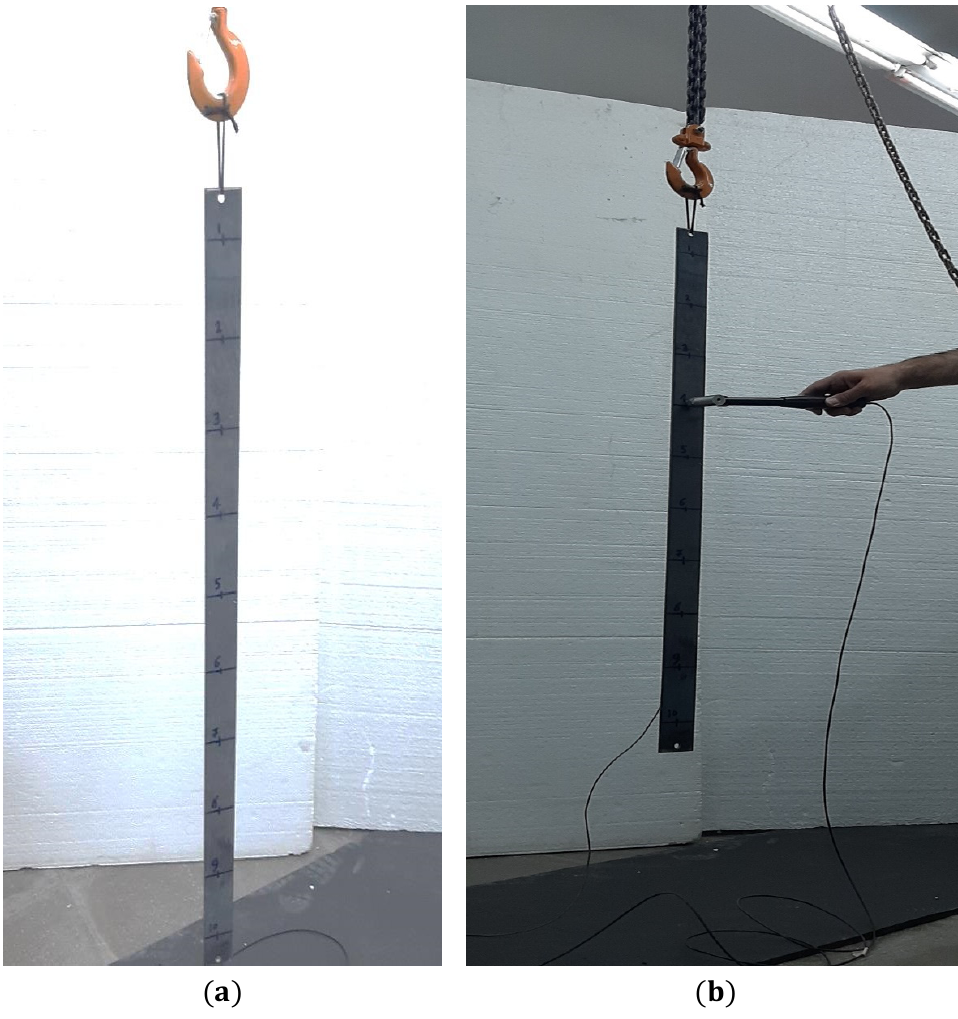
Figure 13. Intact steel beam and its divisions.